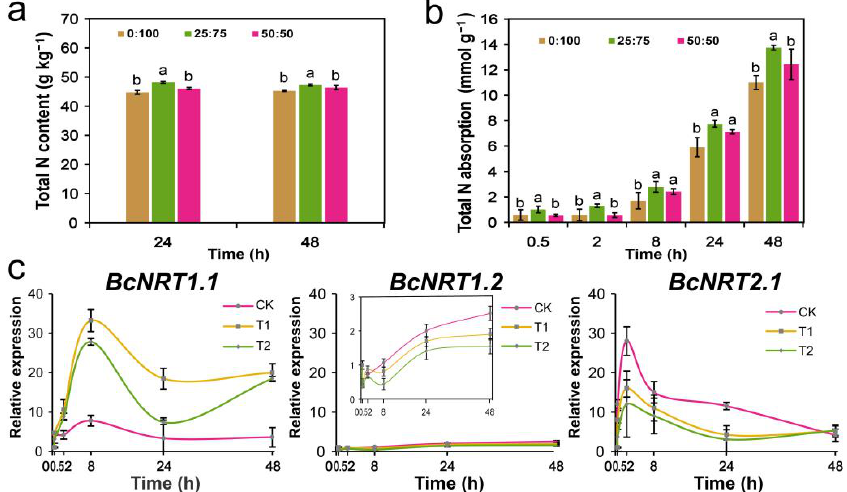
Figure 4. Influence of different NH 4+ /NO 3 − ratios in response to N absorption ( a , b ) and roots NRT genes expression ( c ) of flowering Chinese cabbage, Control= 0/100, T1= 25/75, T2= 50/50. The β -actin gene was used as an internal reference gene. The data represent the mean ± SE ( n = 3). Different letters in Figure 4a,b indicate significant differences at p < 0.05.